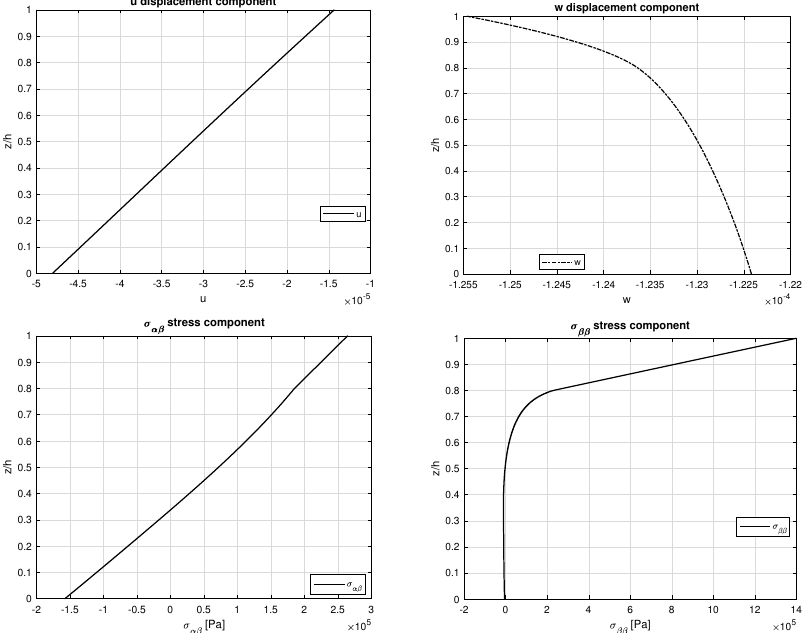
Figure 10. Third benchmark, displacements and stresses for a thick ( R α / h = 10) simply supported sandwich cylindrical shell with FGM ( p = 2) core obtained using the 3D-u- θ model. Maximum amplitudes: w and σ ββ at ( a /2, b /2); u at (0, b /2); σ αβ at (0,0). Table 5. Third benchmark, simply supported sandwich cylindrical shell with FGM ( p = 2)